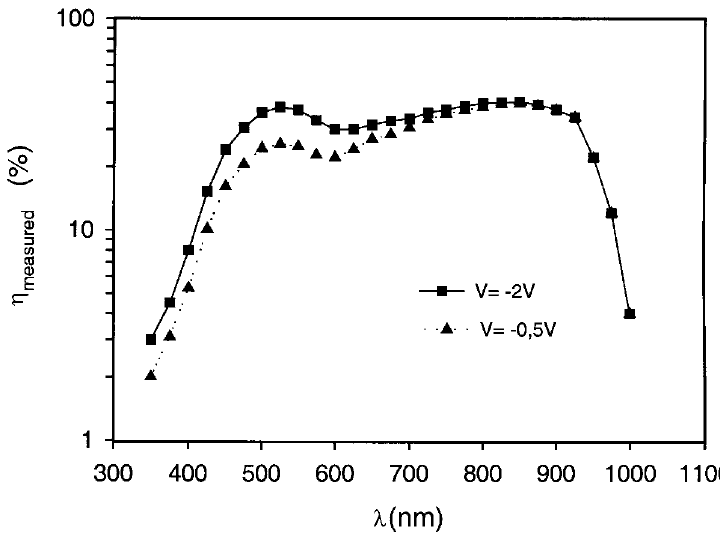
FIGURE 3 Measured quantum efficiency, Z measured , of the Al = a-SiC:H Schottky diode included in the Al = a-SiC:H = c-S(n) = Al structure as a function of the wavelength, l , for a reverse bias voltage V ¼(cid:3) 2V ( j ) and V ¼(cid:3) 0.5V ( m ), and for substrate temperature T s ¼ 120 (cid:1)